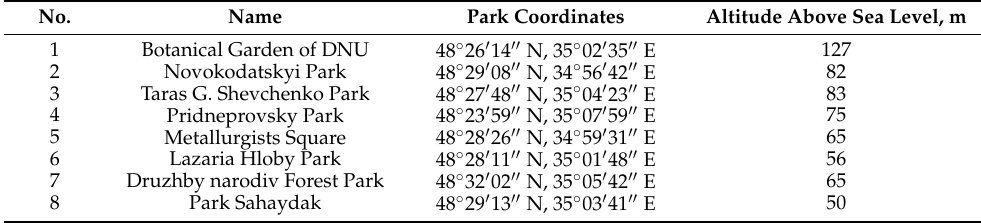
Table 1. Characteristics of research areas.